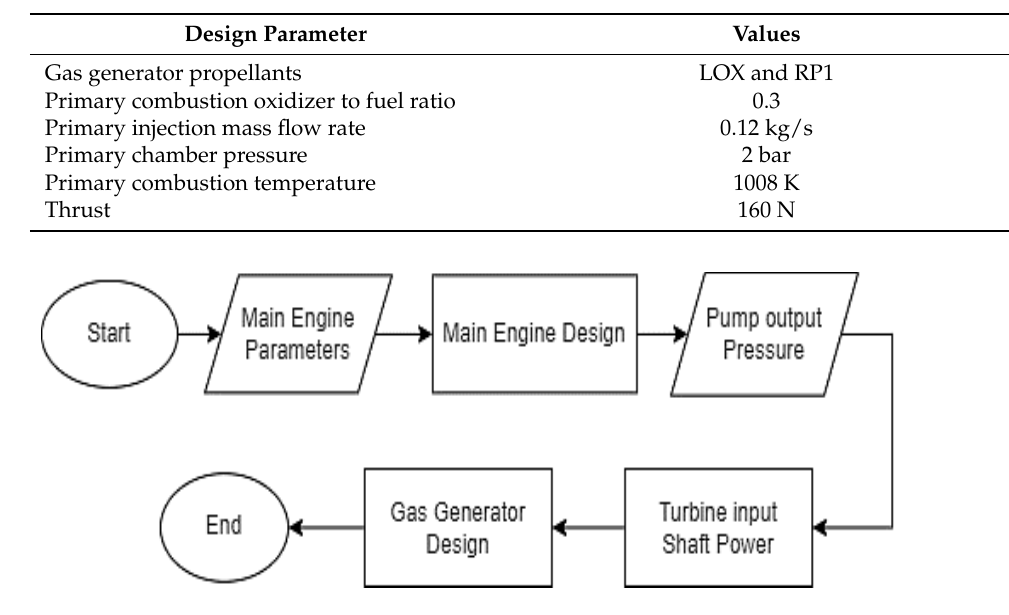
Figure 1. Flow chart for a gas generator LPRE cycle calculation. Table 1. Main rocket engine design parameters.